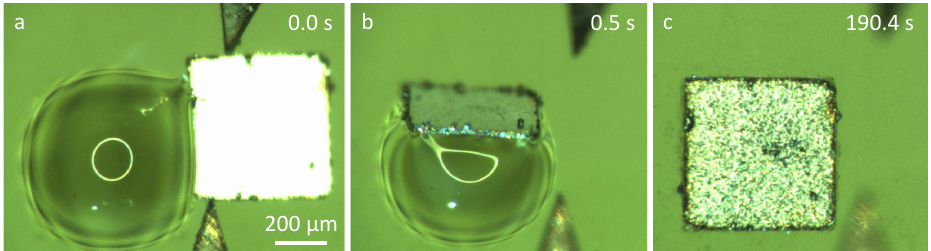
Figure 7. Capillary self-alignment of a 500 µ m ˆ 500 µ m chip with 510 µ m placement bias: ( a ) A chip was ready to be released from the gripper; ( b ) the chip slid down and was aligned to the edge of the pad; ( c ) the droplet evaporated and the chip was aligned with the